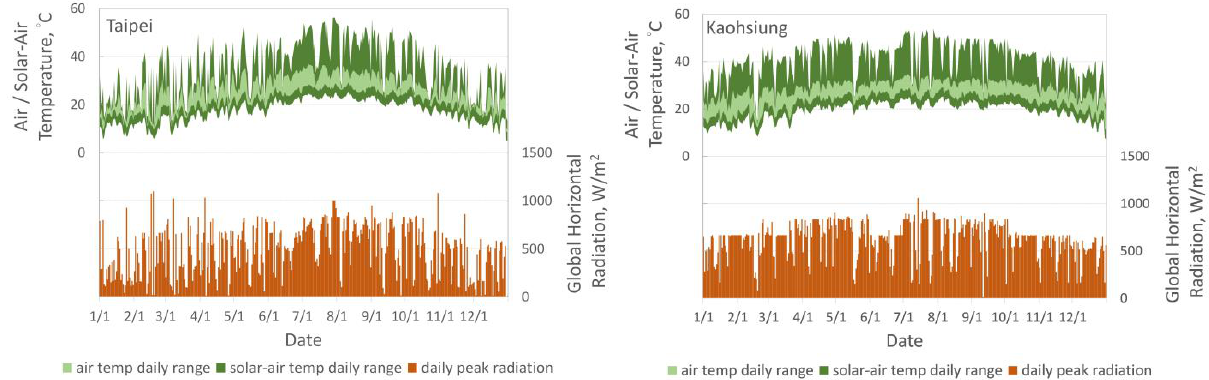
Figure 4. Daily range of air/solar-air temperature and daily peak